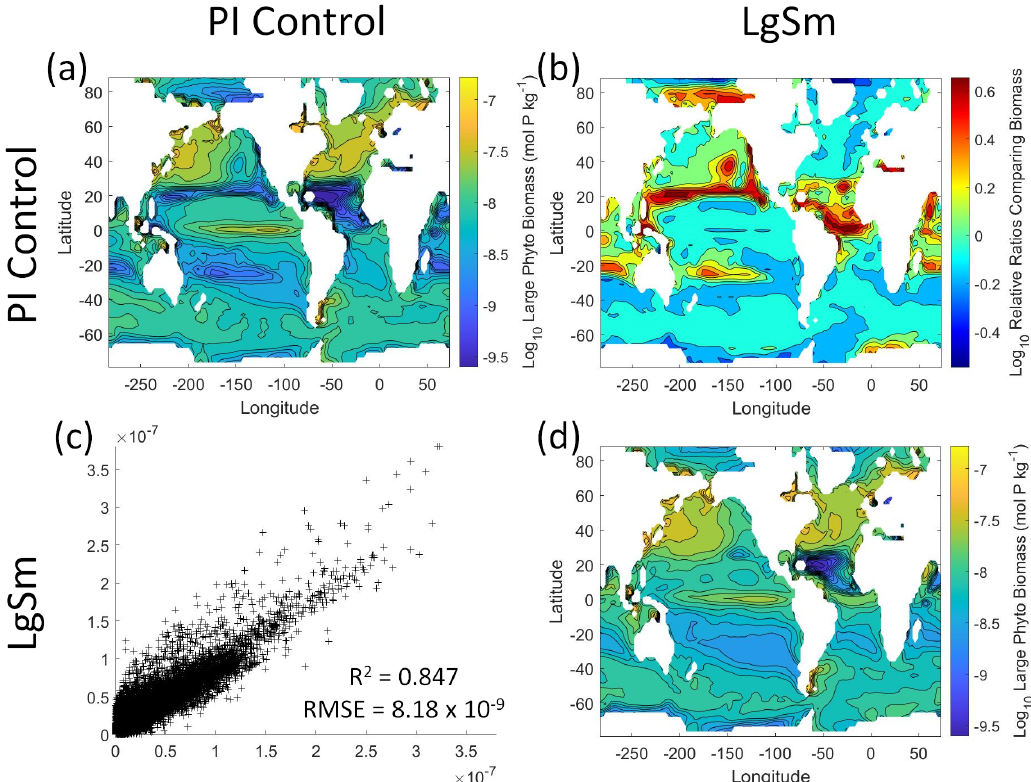
Figure 10. Comparison of the model runs for large phytoplankton biomass in Case 2. The units for biomass in all panels aremolPkg − 1 . The panels show point-by-point scatter plots comparing the model runs against one another (c) , yearly averaged log 10 biomass plots for each model run (a, d) , and the log 10 relative ratios comparing the yearly averaged contour plots of the model runs (b) . The x axis and y axis of the scatter plots (c) correspond to the horizonal and vertical model run labels, respectively (e.g., panel c shows PI Control on the x axis and LgSm on the y axis). The yearly averaged log 10 contour plots (a, d) correspond to the matching horizontal and vertical model run labels (e.g., panel a shows the yearly averaged log 10 biomass of PI Control). The log 10 relative ratios (b) were calculated as the model run listed on the horizontal axis divided by the model run listed on the vertical axis (e.g., panel b shows LgSm divided PI